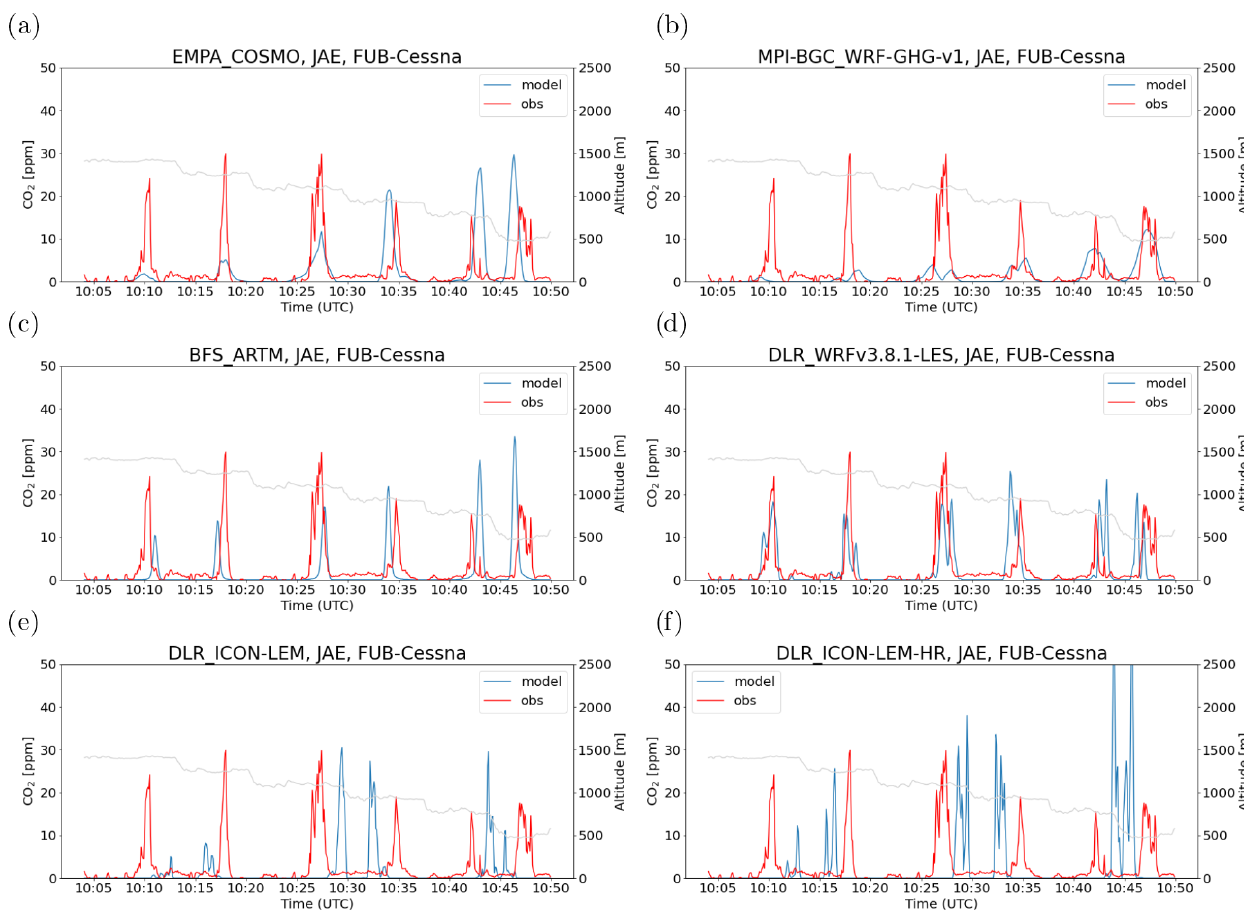
Figure 8. Time series of CO 2 (tracer CO2_PP_M) along the FUB Cessna flight at Jänschwalde on 23 May 2018. The gray line is the flight altitude (second y